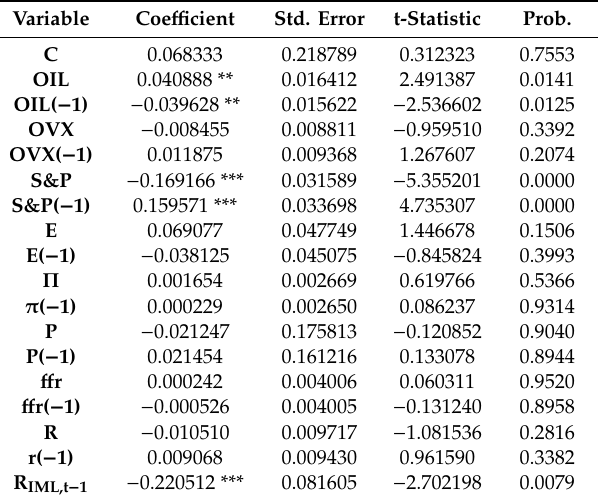
Table 15. Long-run ARDL model (full sample).